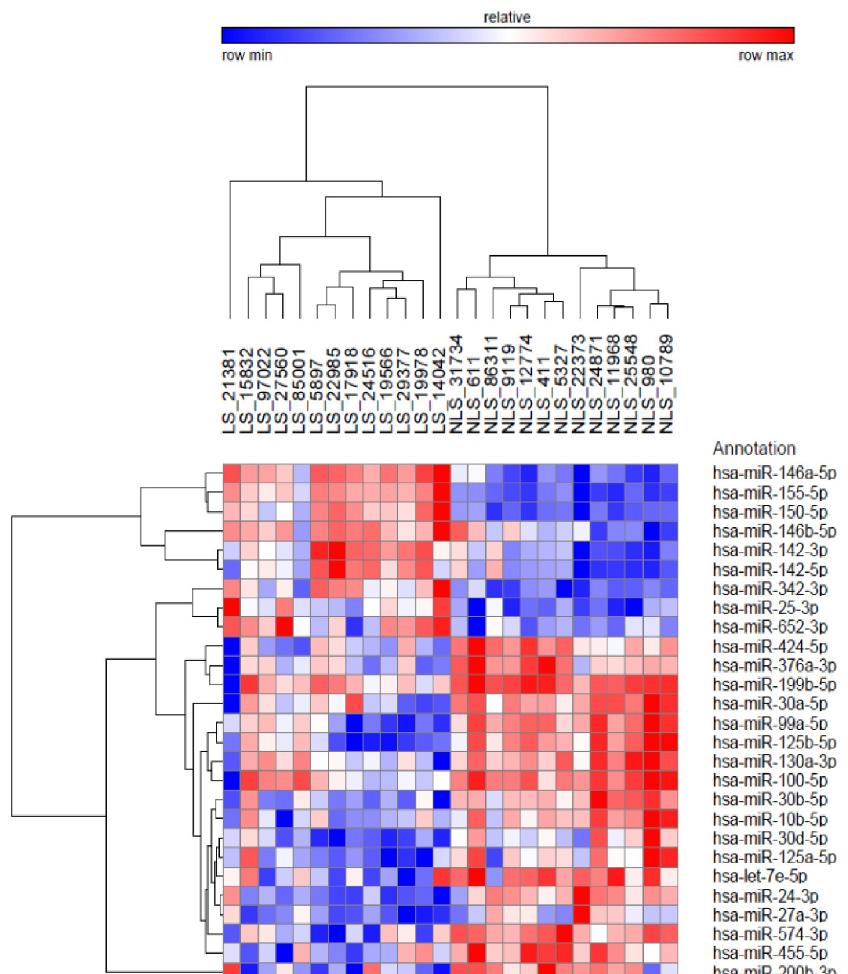
Fig 2. Hierarchical clustering analysis. Hierarchical clustering analysis of the 26 samples included in the screening analysis using the 27 differentially expressed miRNAs (FDR < 0.01) identified between LS and non-LS USD.